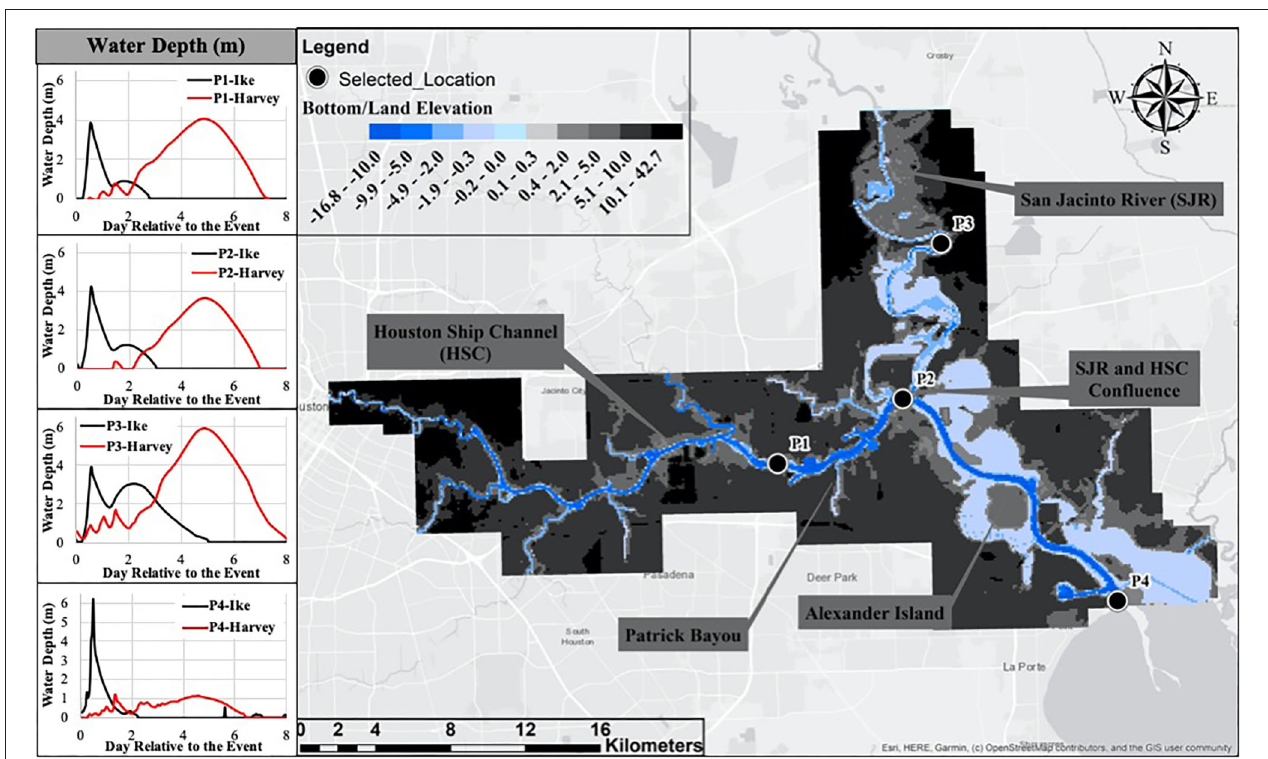
FIGURE 6 | Bottom/land elevation in the study area and water depth time-series at several originally dry (dry at mean sea level) locations of the study area during Hurricanes Ike and